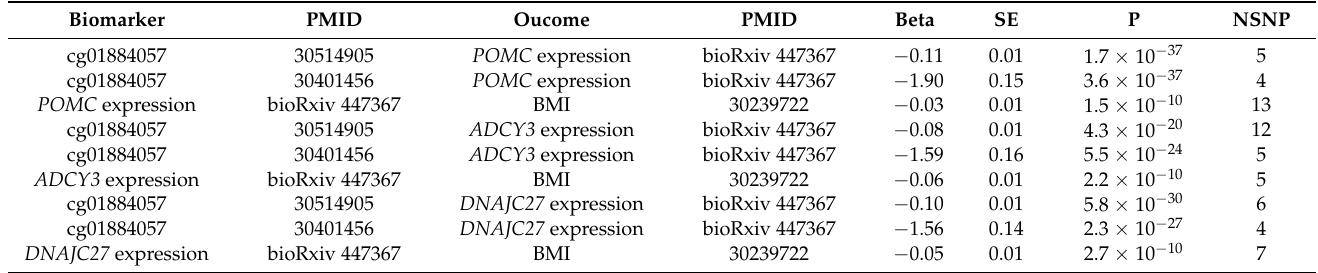
Figure 5. Understanding the function of rare variants using the available knowledge on nearby common SNPs. In this example, we noted that ( A ) rare variants (red squares) within the 2p23.3 locus overlap with mQTLs (blue circles) for a methylation site (cg01884057) within this locus. ( B ) MR analysis revealed that higher methylation at this site was associated with a higher BMI. Methylation at this site was also associated with lower expression of POMC , ADCY3 and DNAJC27 (Table 1). Therefore, rare variants within this locus impact obesity by making this site more inclined to methylation, which consequently lowers the expression of POMC , ADCY3 and DNAJC27 . Each point on MR plots represents a SNP; the x-value of a SNP is its β effect size on the exposure, and the horizontal error bar represents the standard error around the β . The y-value of the SNP is its β effect size on the outcome, and the vertical error bar represents the standard error around its β . The dashed line represents the line of best fit (a line with the intercept of 0 and the slope of β from the MR test). Table 1. Summary association statistics for the mechanism whereby the cg01884057 site contributes to obesity. Biomarker